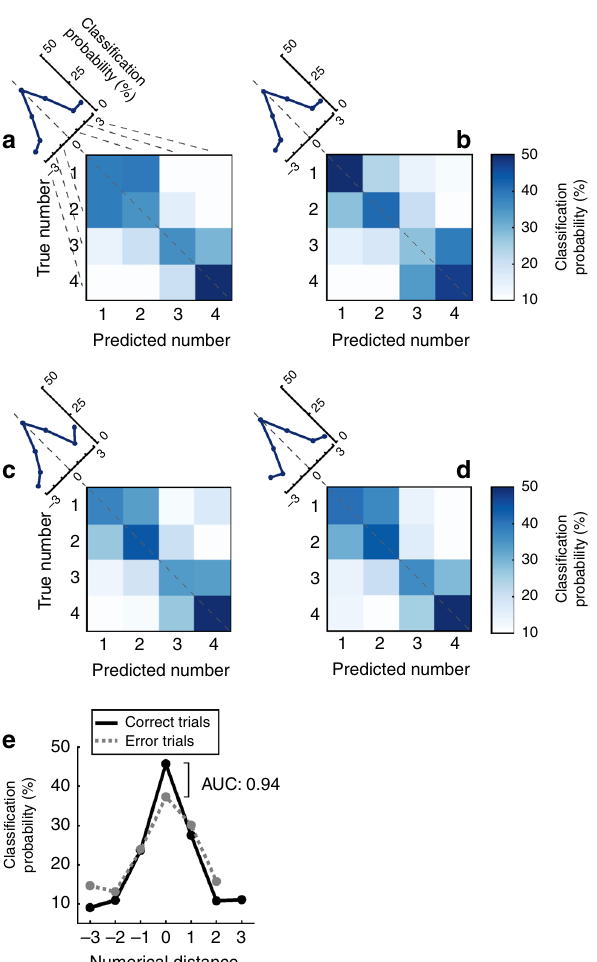
Fig. 6 Population decoding during the delay based on the SVM classi fi er. a – e Decoding accuracy based on the SVM classi fi er. Confusion matrices ( a – d ) derived from training classi fi ers on fi ring rates from the delay phase. Rows indicate the true numerosity that the crow has seen, and the columns the predicted numerosity. Tuning functions at the end of the confusion matrix ’ diagonal depict average classi fi cation probability over all numerosities. The confusion matrices in a – d differ in the data that were used for training and testing. a Accuracy of the classi fi er trained and cross- validated on delay fi ring rates after presentation of sequential numerosities. b as in a but with a preceding simultaneous numerosity. c Accuracy of the classi fi er trained with fi ring rates when the sample was presented sequentially, then tested with fi ring rates from simultaneous trials. d Accuracy of the classi fi er trained with fi ring rates when the sample was presented simultaneously, then tested with fi ring rates from sequential trials. e Average classi fi cation probability when tested with correct and error trials. Chance level is 25%.